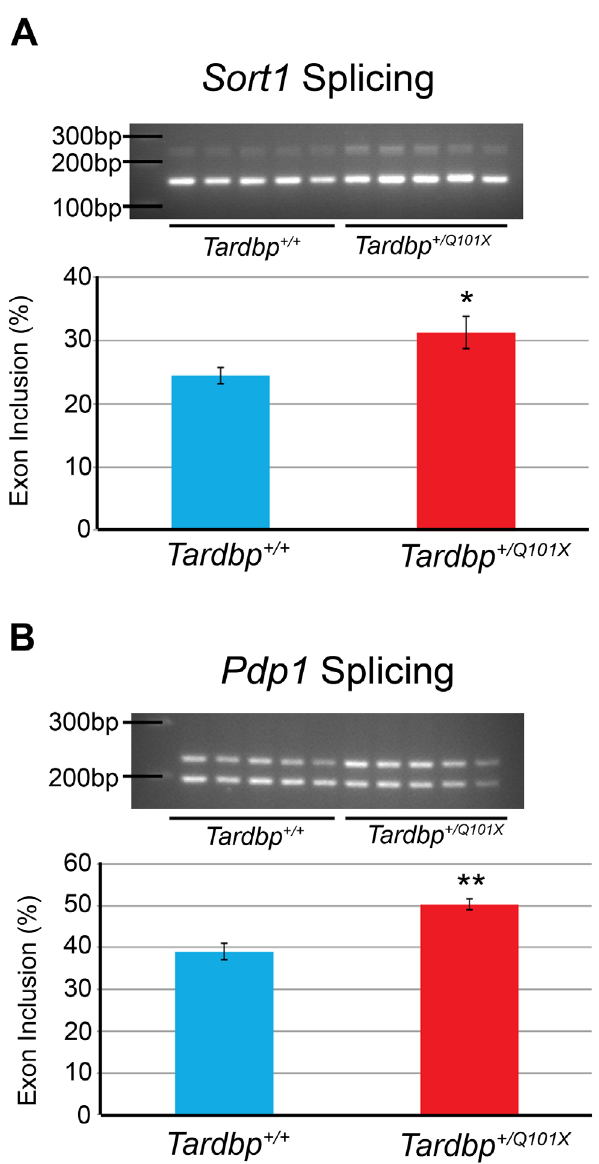
Figure 2. The Q101X mutation in Tardbp alters splicing of TDP43 targets Sort1 and Pdp1 . ( A ) Exon inclusion of Sort1 , determined from cDNA generated from brain from 18-month old mice, is significantly increased in Tardbp + /Q101X (n=5) mice compared to Tardbp + / + mice (n=5). Bar charts show abundance of exon-included transcript relative to total transcript (included and excluded). Sort1 exon inclusion: Tardbp + / + 24.4% 6 1.3% versus Tardbp + /Q101X 31.3% 6 2.6%, p=0.044 (student’s two-tailed t-test). Data are mean 6 SEM. ( B ) Exon inclusion of Pdp1 is also significantly increased in brain tissue from Tardbp + /Q101X mice at 18 months of age. Exon inclusion: Tardbp +